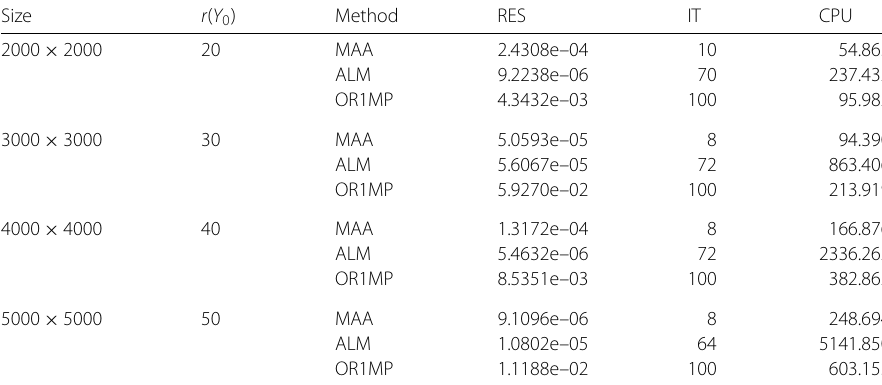
Table 2 Comparison results of three methods for p = 0.2